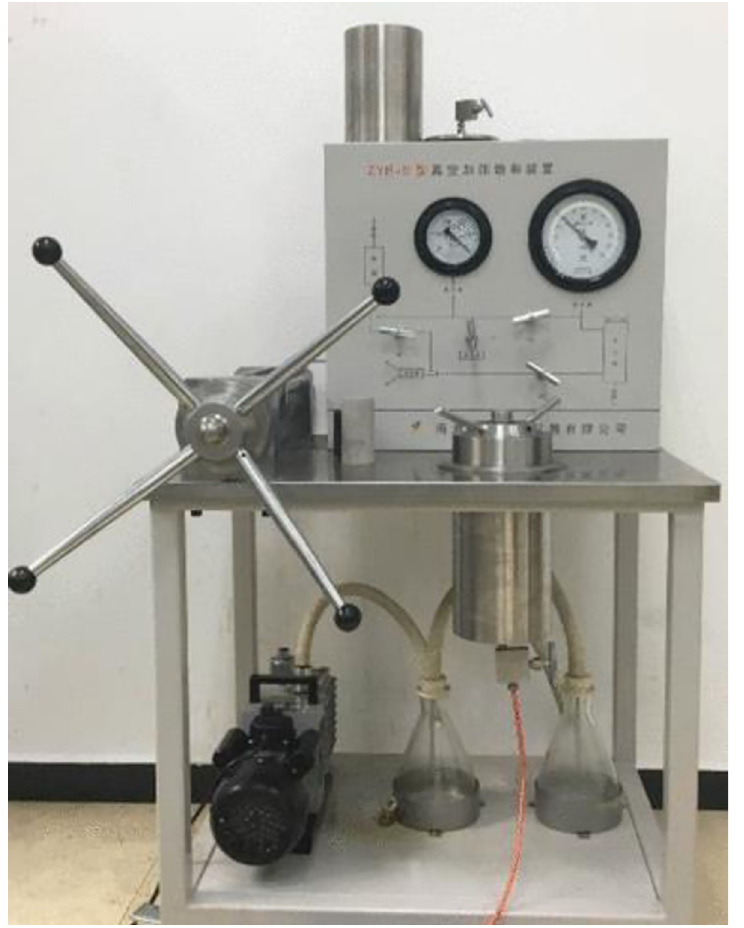
Fig 4. Water-saturated apparatus [33].